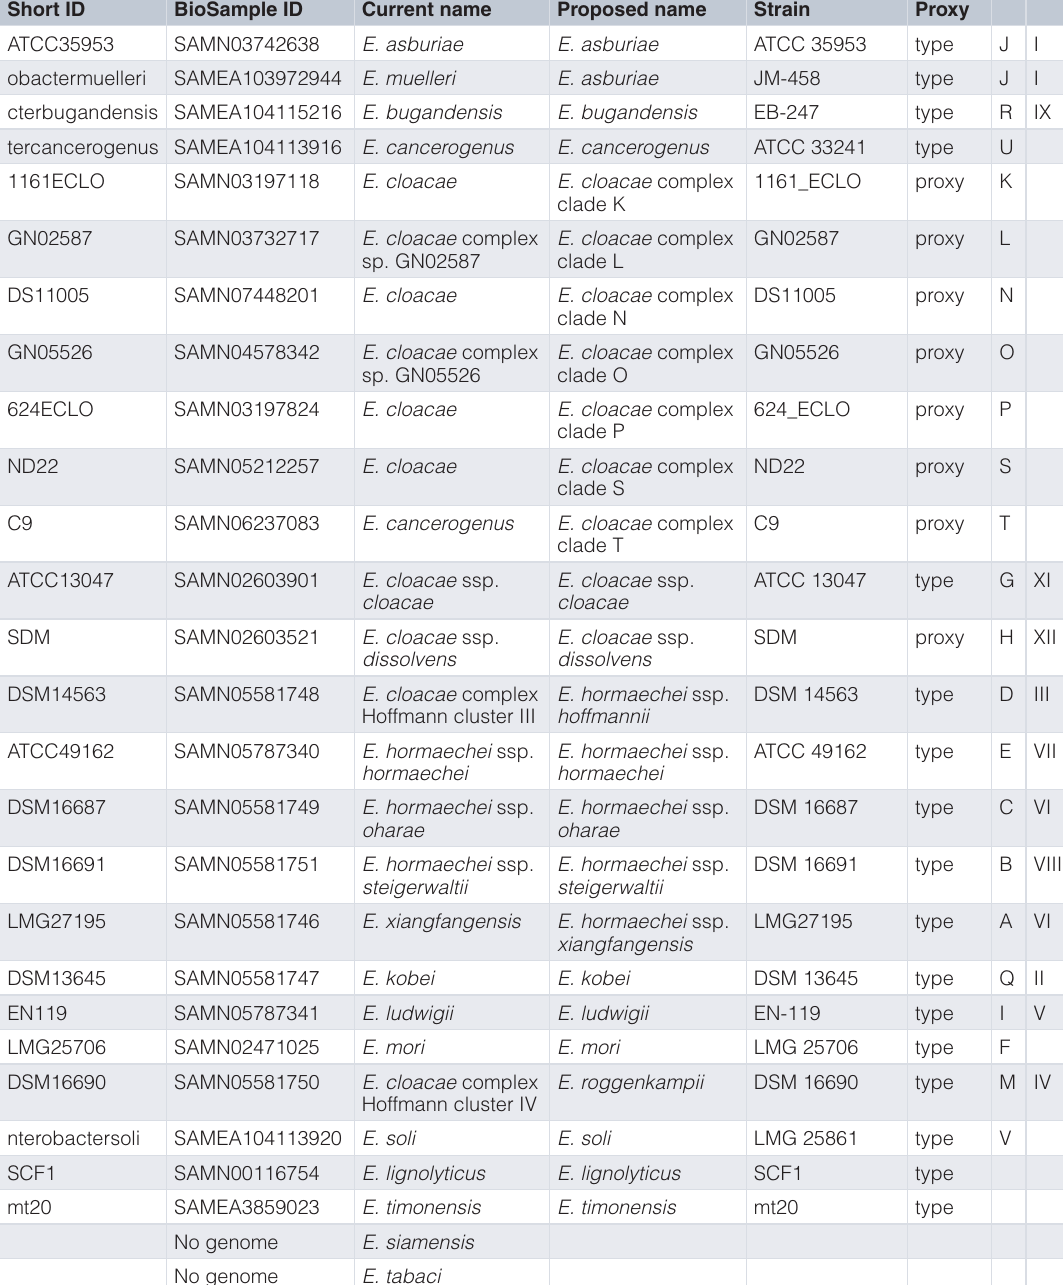
Table 1. Type and proxy strain genomes for Enterobacter cloacae complex clades. E. lignolyticus and E. timonensis have not been validly published and are deemed to be outside of the E. cloacae complex. E. siamensis and E. tabaci do not have sequenced genomes but based on their 16S rRNA genes may be in the E. cloacae complex. Proxy indicates whether a type or proxy strain was available. The last two columns are for the clade (A-V) and Hoffmann cluster